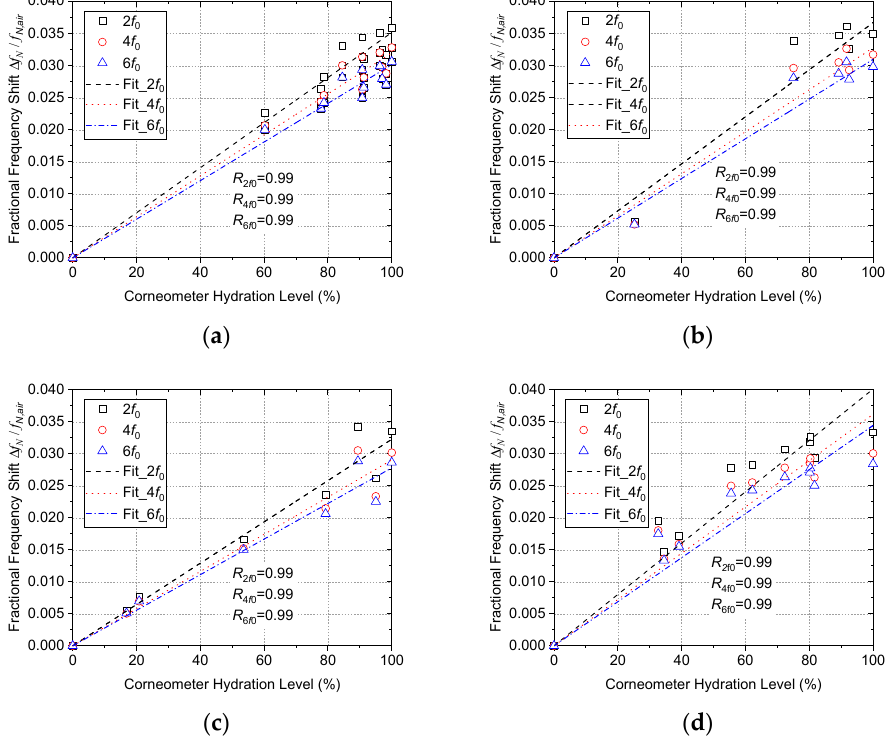
Figure 11. Correlation between Corneometer reading and fractional frequency shift data of the first three even harmonic resonances, ( a ) cervical sample A (030215), ( b ) cervical sample B (DT6070), ( c ) cervical sample C (WE4388), ( d ) cervical sample D (180316). In terms of sensitivity, the proposed sensor shows mean fractional frequency shift of (3.3 ± 0.3) × 10 − 4 per unit % over the entire data collected (e.g., four different samples and three harmonic resonances). This translates into an absolute frequency shift ( ∆ f N ) of 252 ± 23 kHz/%, 455 ± 41 kHz/%, and 647 ± 57 kHz/% at second, fourth, and sixth harmonic resonance,